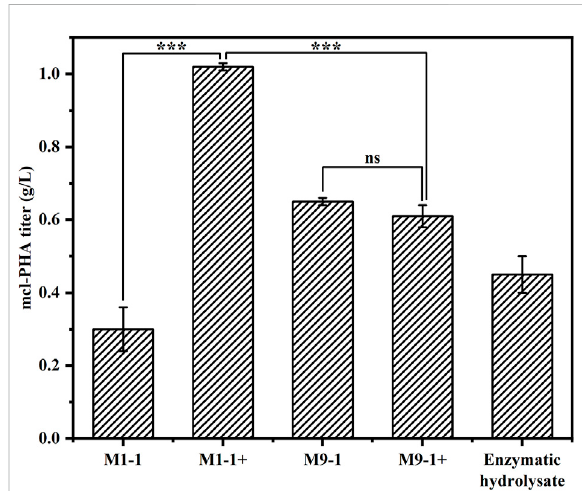
FIGURE 6 The production of mcl-PHA using lignocellulosic biomass by the P. putida - E. coli microbial consortium. M1-1: The ratio of acid- pretreatment solution of corn straw and M9 medium was 1:1; M1- 1+: The ratio of acid-pretreatment solution of corn straw and M9mediumwas1:1and10 g/Lglucosewasadded.M9-1:Theratio of acid-pretreatment solution of corn straw and M9 medium was 9:1; M9-1+: The ratio of acid-pretreatment solution of corn straw and M9 medium was 9:1 and 10 g/L glucose was